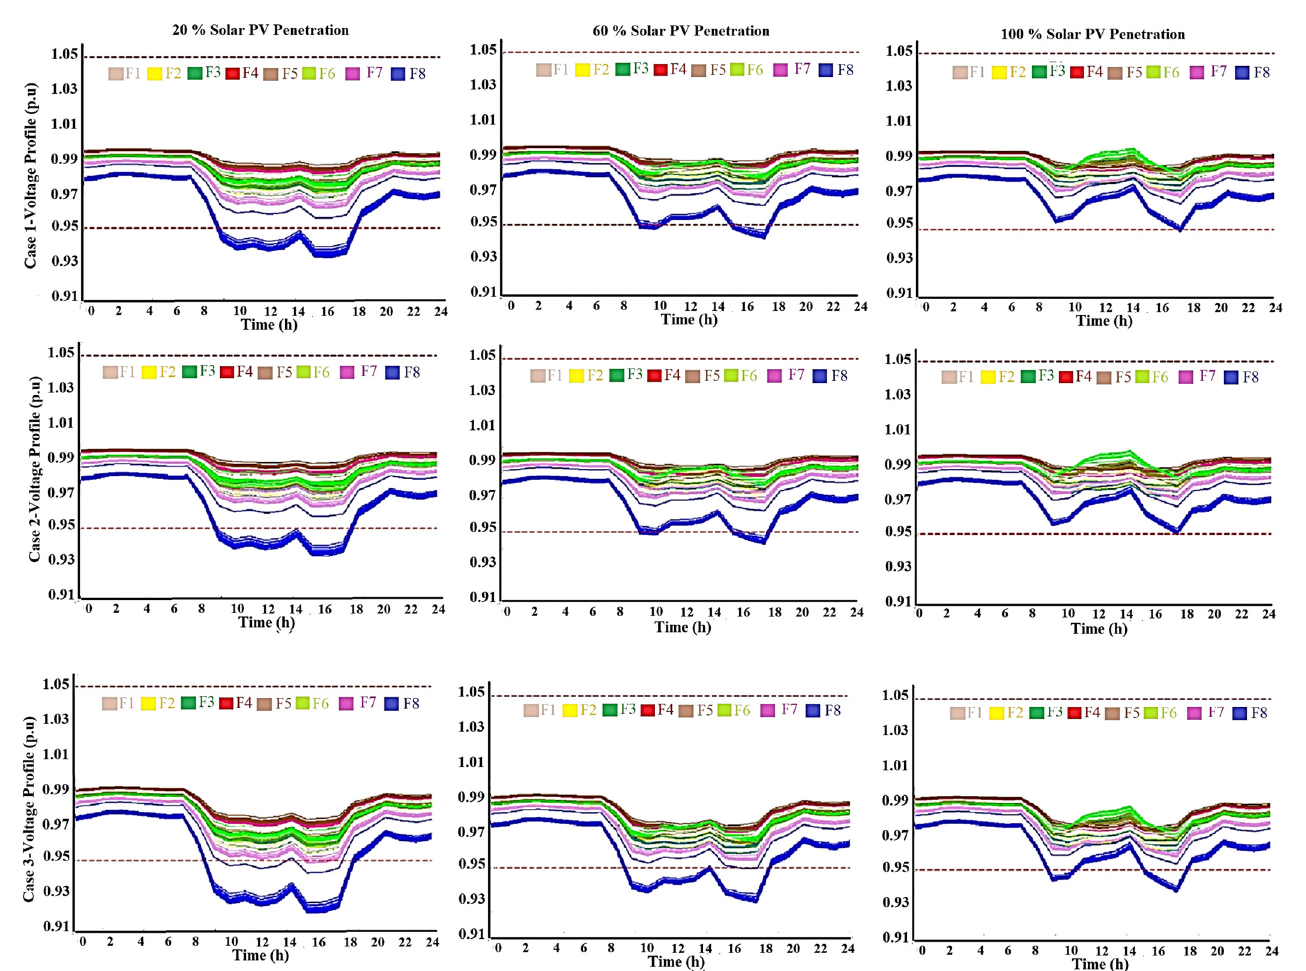
Figure 7. Comparing the dynamics of PV penetration level at peak loads for all case